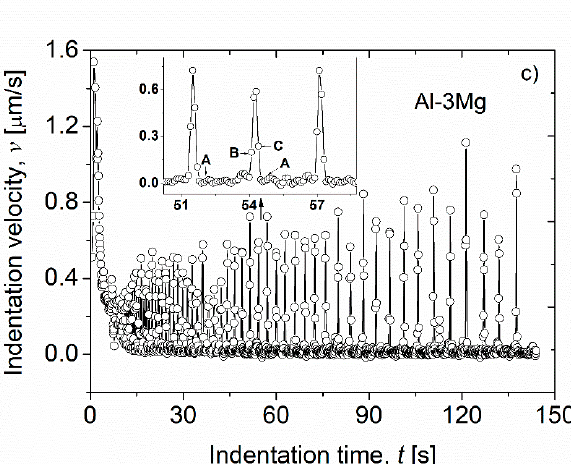
Figure 4. Demonstration of plastic instabilities during indentation: ( a ) Typical indentation depth-load ( h-F ) curves [30], ( b ) changes of the corresponding microharness, HV as a function of the indentation depth, h [30] and ( c ) the changes of the indentation velocity, v as a function of the indentation time, t in the case of the Al-3Mg alloy showing indentation instability [31]. Reproduced with permission from [30,31]. Copyrights 2004, Materials Research Society and 2005,